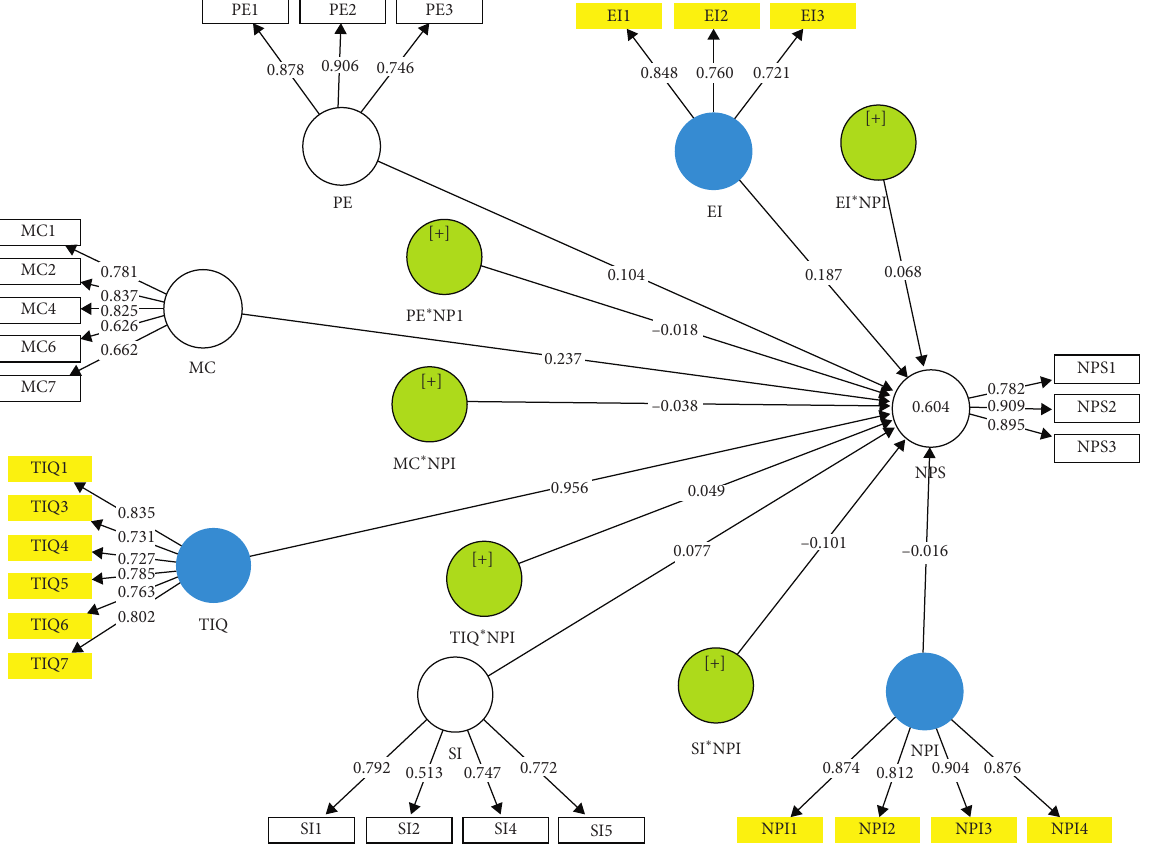
Figure 5: Measurement assessment model. Table 4: Heterotrait-Monotrait